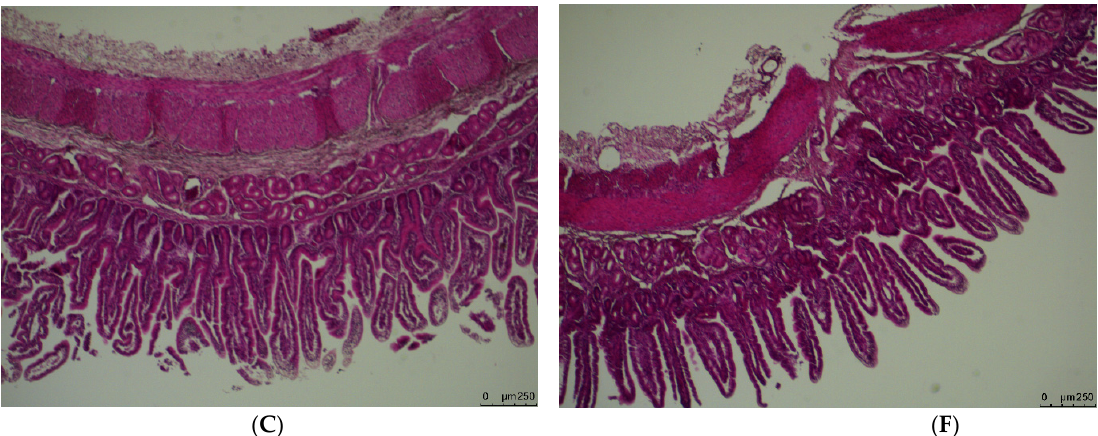
Figure 3. Morphological characteristics of duodenal cross-section of newborn lambs that were fed folic acid by the mother during pregnancy. ( A – C ) are cross-sections from twin-born lambs from ewes fed 0, 16 or 32 mg·(kg DM) − 1 folic acid in the basal diet, respectively; ( D – F ) are cross-sections from triplet-born lambs from ewes fed 0, 16 or 32 mg·(kg DM) − 1 folic acid in the basal diet, respectively.